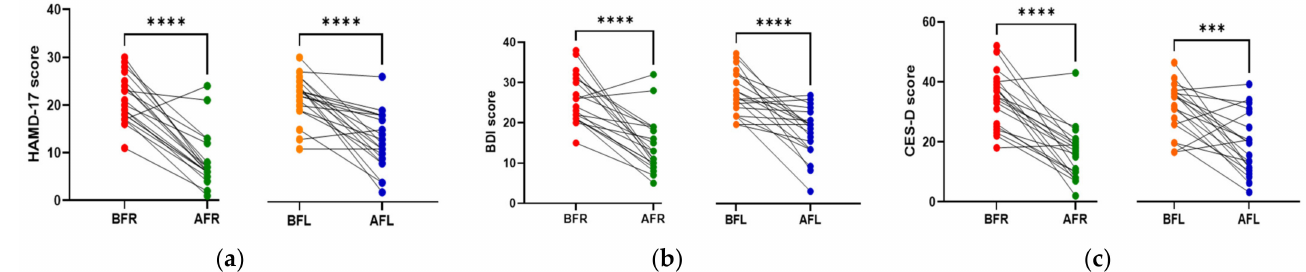
Figure 3. Differences between flavonoid-rich orange juice group or flavonoid-low orange cordial group before and after the intervention. ( a , b ) Post-intervention, the HAMD-17 and BDI-II scores in the AFR and AFL groups decreased significantly ( p < 0.0001) compared to those of the BFR and BFL groups. ( c ) CES-D scores in the AFR ( p < 0.0001) and AFL ( p < 0.001) decreased significantly compared to those of the BFR and BFL groups. BFR: Before flavonoid-rich orange juice group, AFR: after flavonoid-rich orange juice group, BFL: before flavonoid-low orange cordial group, AFL: after flavonoid-low orange cordial group. BDI-II, Beck Depression Inventory-II; CES-D, Center for Epidemiological Studies Depression Scale; HAMD, Hamilton Depression Rating Scale. *** p < 0.001; **** p <